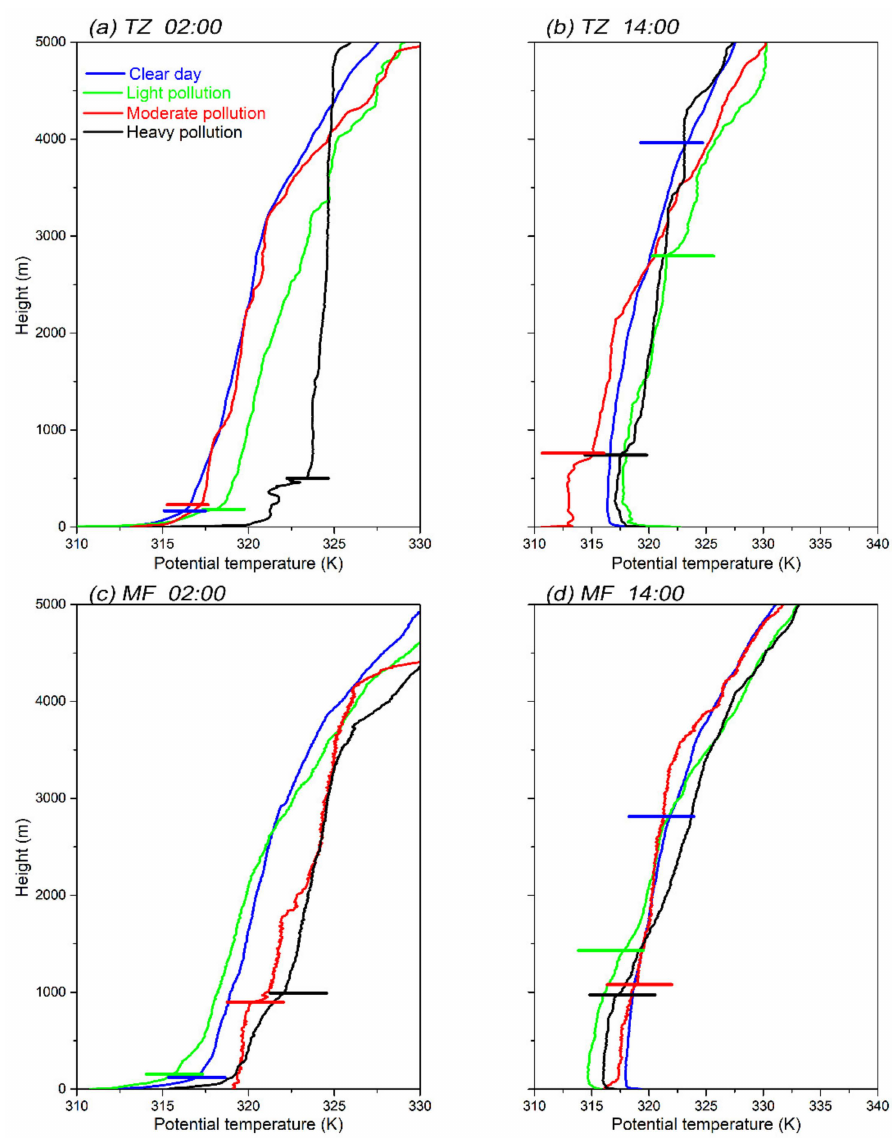
Figure 9. Vertical distribution of potential temperature under different pollution conditions during July 2021 in TZ and MF. ( a ) 02:00, TZ; ( b ) 14:00, TZ; ( c ) 02:00, MF; ( d ) 14:00,